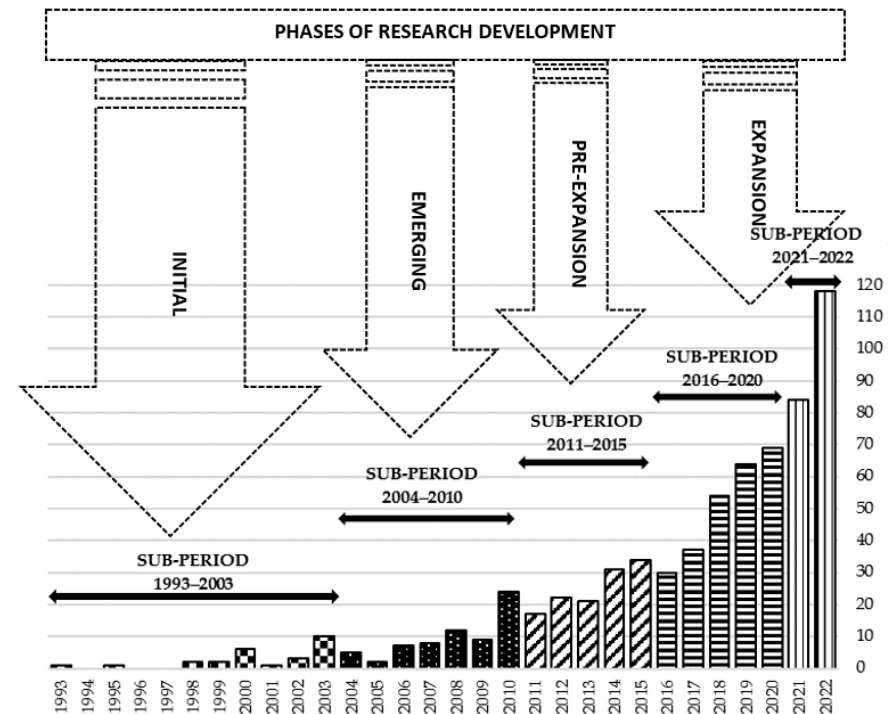
Figure 4. The number of publications per year by sub-period and phase of research